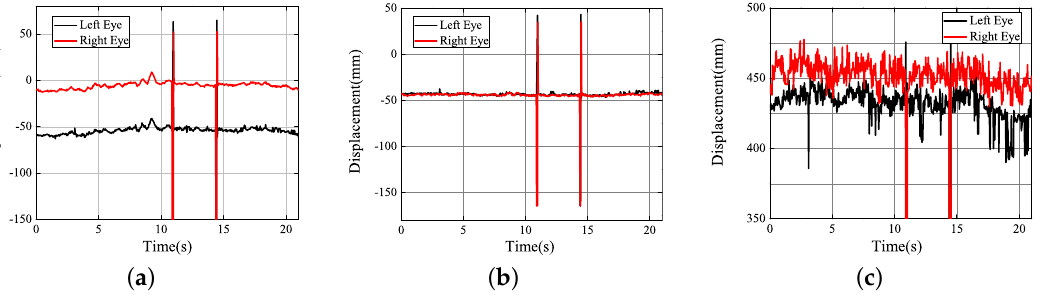
Figure 20. Experimental results obtained (10 km/h): ( a ) X axis; ( b ) Y axis; ( c ) Z axis.